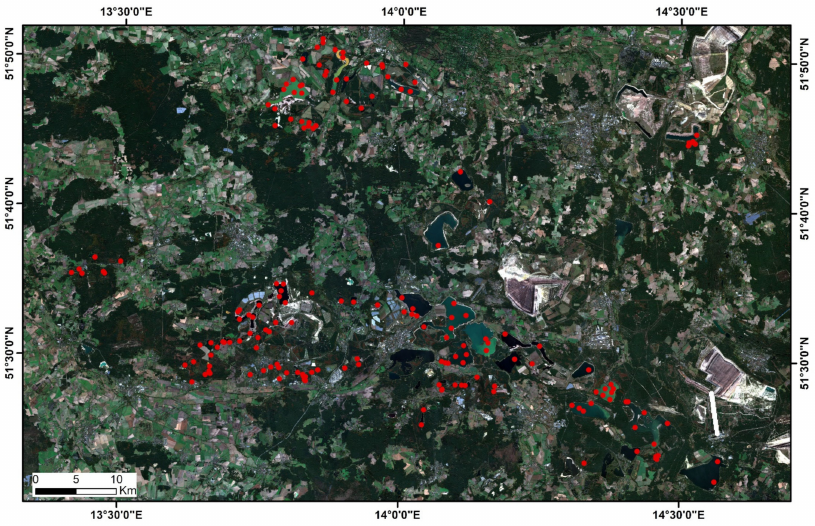
Figure 2. Location of the water monitoring points in the Lusatian post-mining water